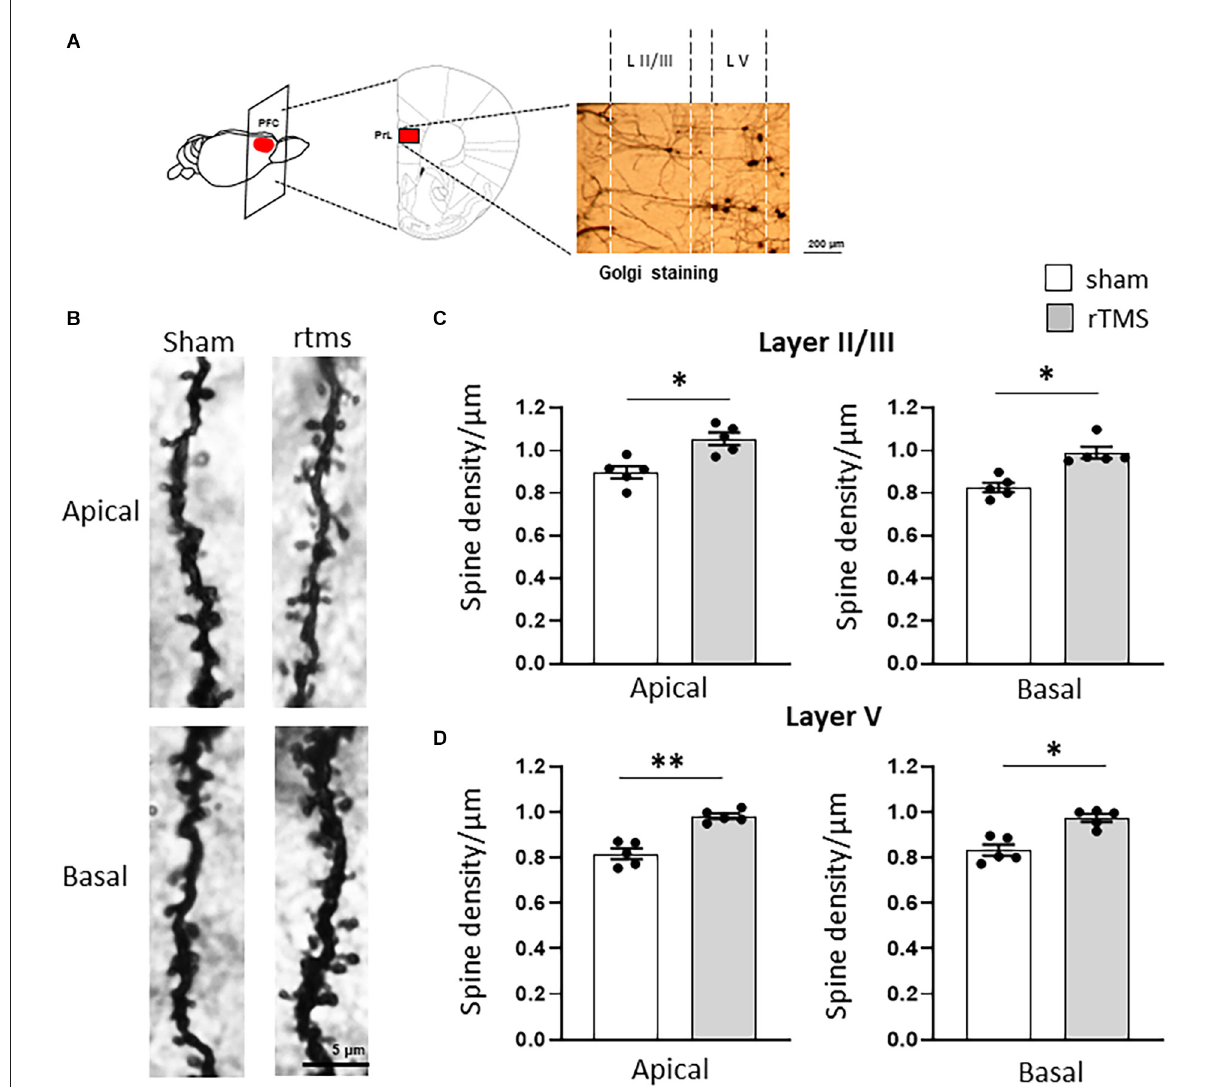
FIGURE3 HF-rTMS modulates apical and basal dendritic spines in layer II/III prefrontal neurons within the prelimbic area. (A) Schematic of the stimulated brain area and representative Golgi staining of the analyzed region of interest (scale bar = 200 µ m). (B) Representative images of apical and basal dendrites for the sham and rTMS conditions (L II/III). Stimulation resulted in a significantly increased spine density in both apical and basal dendrites of layer II/III (C) and layer V (D) (scale bar = 5 µ m). Means ± SE. ∗ p < 0.05, ∗∗ p <